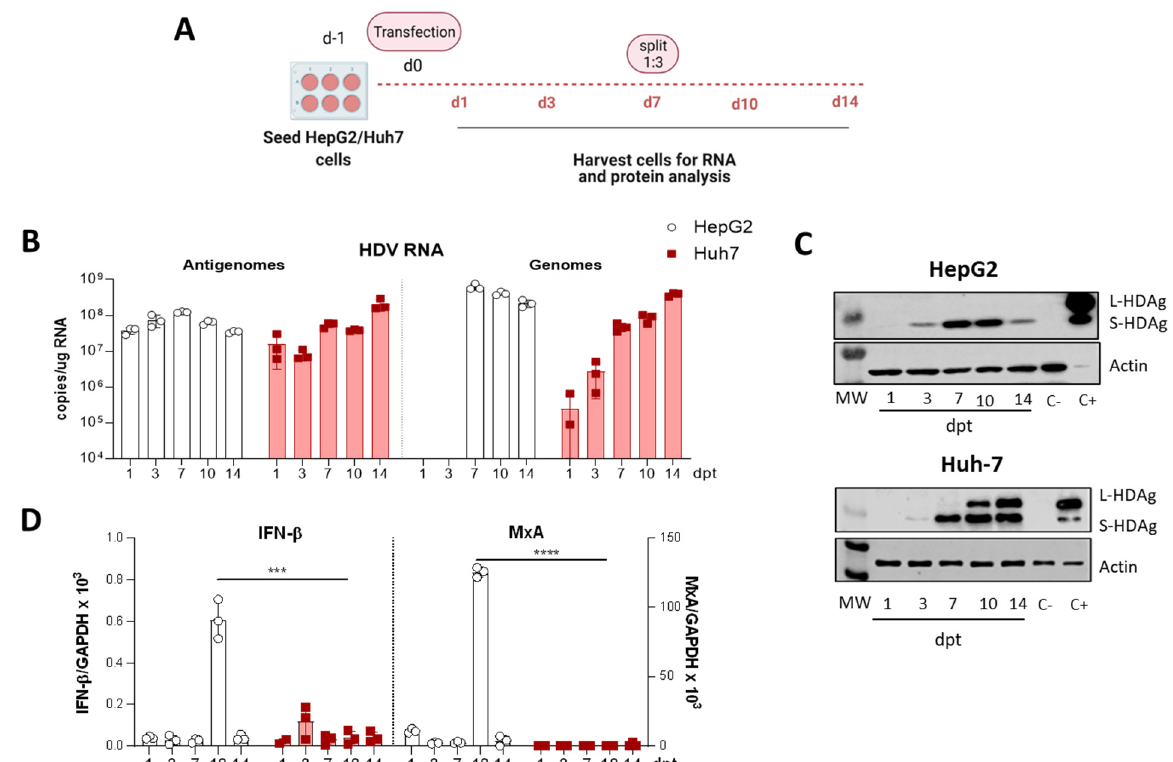
Figure 1. The HDV life cycle is supported in Huh-7 cells upon transfecting HDV-encoding plasmid but not in HepG2 cells. ( A ) Schematic representation of the experimental layout. HepG2 or Huh-7 cells were seeded and transfected with equal amounts of the plasmid encoding the HDV antigenome. For RNA and protein analysis, cells were collected at 1-, 3-, 7-, 10- and 14-days post-transfection (dpt), and cells were split 1:3 at 7-dpt. ( B ) Total RNA was extracted from cells and HDV antigenome and genome levels were assessed by RT-qPCR. ( C ) Western Blot analysis of HepG2 and Huh-7 cell lysates was performed to detect S-HDAg and L-HDAg. Positive control (C+): Huh-7 cells transfected with plasmids expressing S-HDAg and L-HDAg antigens and collected at 3 dpt. Negative control (C-): non transfected Huh-7 or HepG2 cells. ( D ) IFN- β (left) and MxA (right) expression levels were quantified by RT-qPCR and normalized using GAPDH as housekeeping gene. Statistical analysis using Mann–Whitney test revealed differences between the two cell lines (*** p < 0.001, **** p < 0.0001).